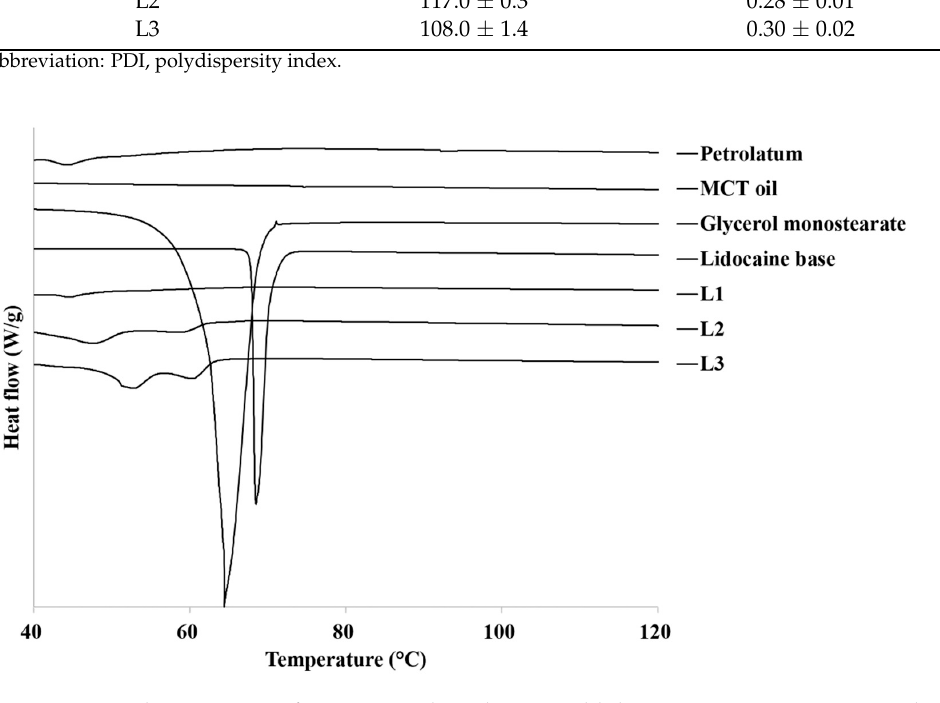
legend. The correct Figure 2 appears below.